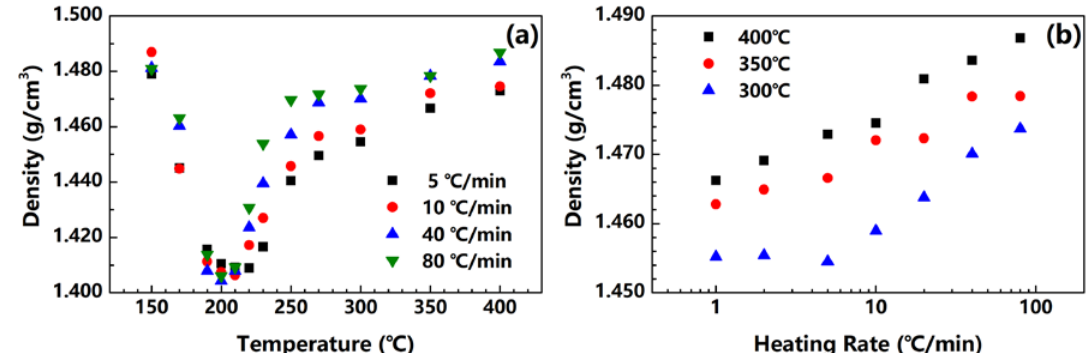
Figure 4. ( a ) Density change in fibers under different heating rates; ( b ) density of PI fibers obtained at 300, 350 and 400 °C under different heating rates.